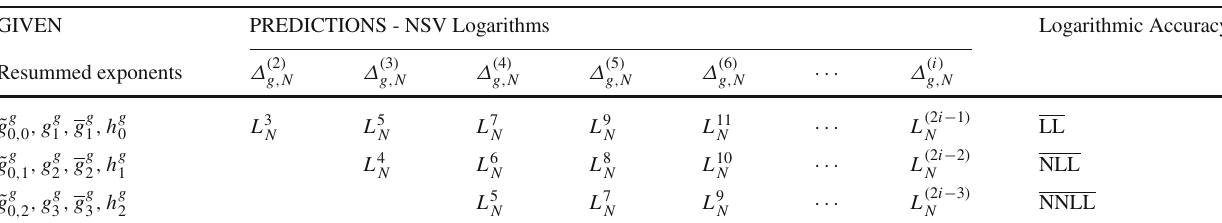
Table 2 The set of resummed exponents logarithmic accuracy. Here L j